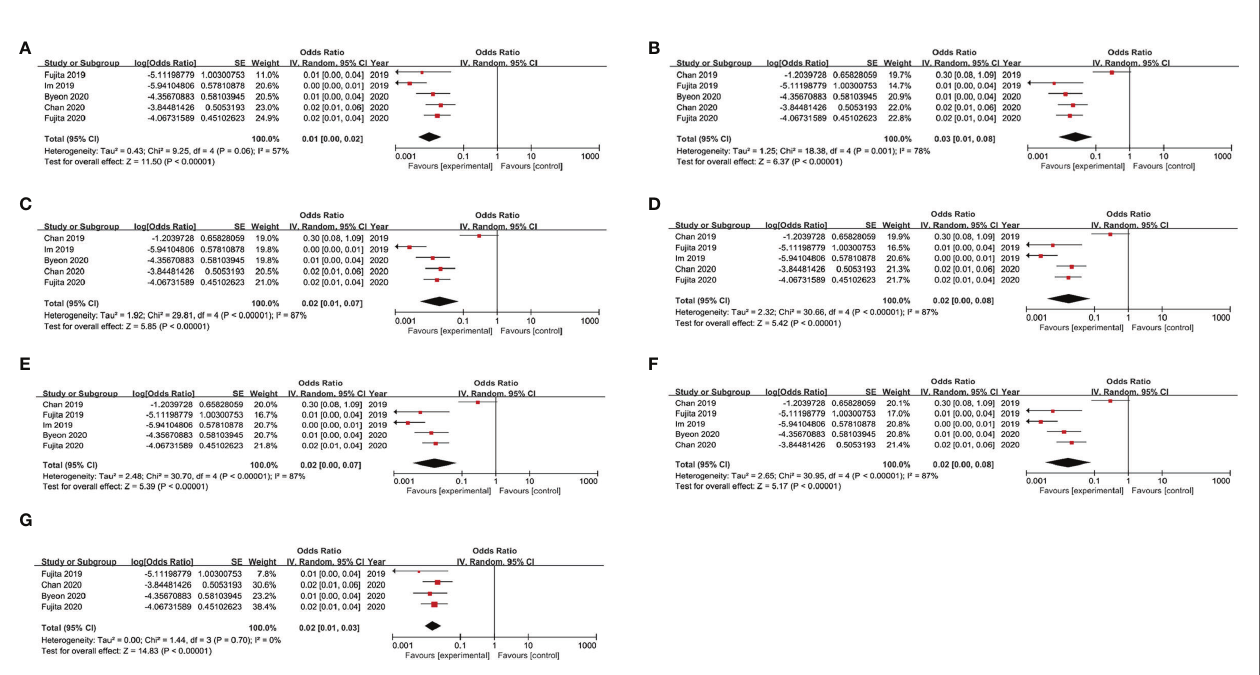
FIGURE 4 | Results of sensitivity analysis after removing each study in turn. (A) Sensitivity analysis by removing Chan 2019; (B) Sensitivity analysis by removing Im 2019. (C) Sensitivity analysis by removing Fujita 2019. (D) Sensitivity analysis by removing Byeon 2020. (E) Sensitivity analysis by removing Chan 2020. (F) Sensitivity analysis by removing Fujita 2020. (G) Sensitivity analysis by removing the Chan 2019 and Im